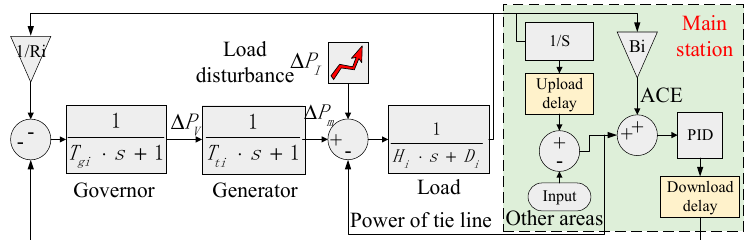
Figure 5. Load frequency control block diagram of an area in a multi-area delayed power system.